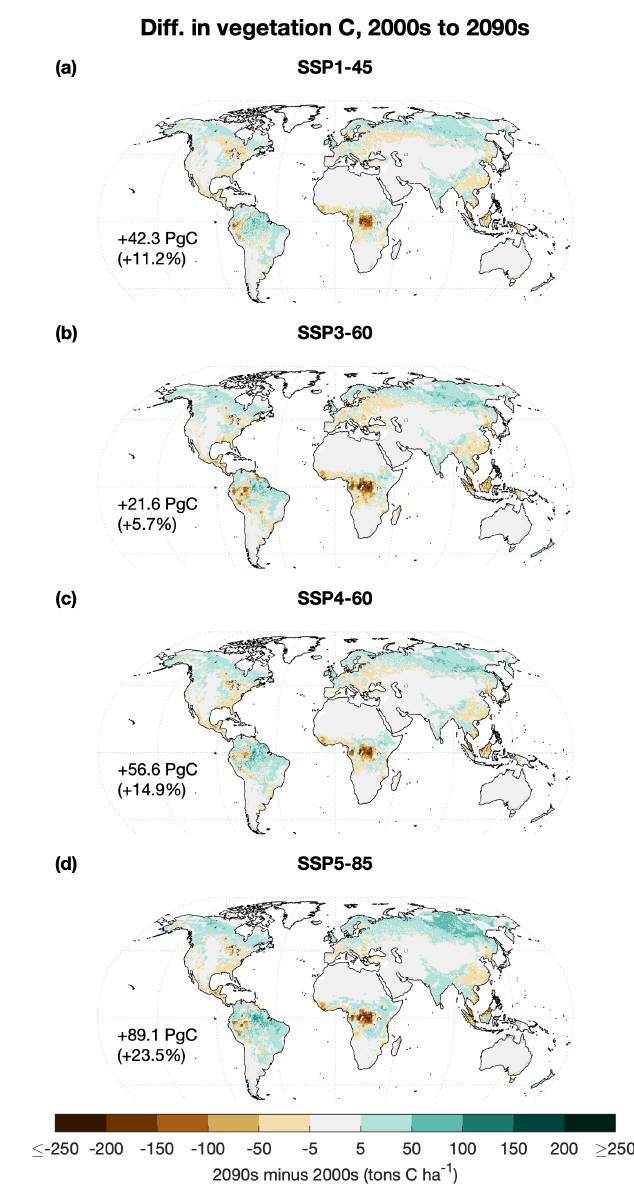
Figure 5. Maps showing difference in mean vegetation car- bon between 2001–2010 (“2000s”) and 2091–2100 (“2090s”) for